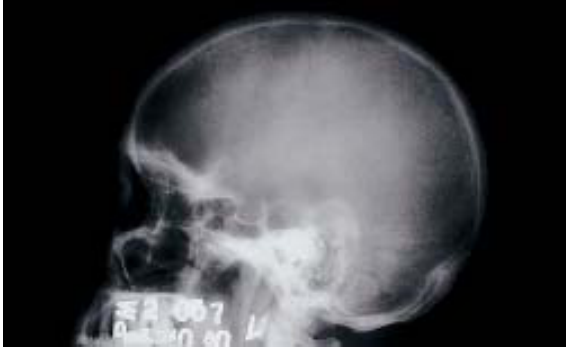
Figure 1. Pepper pot